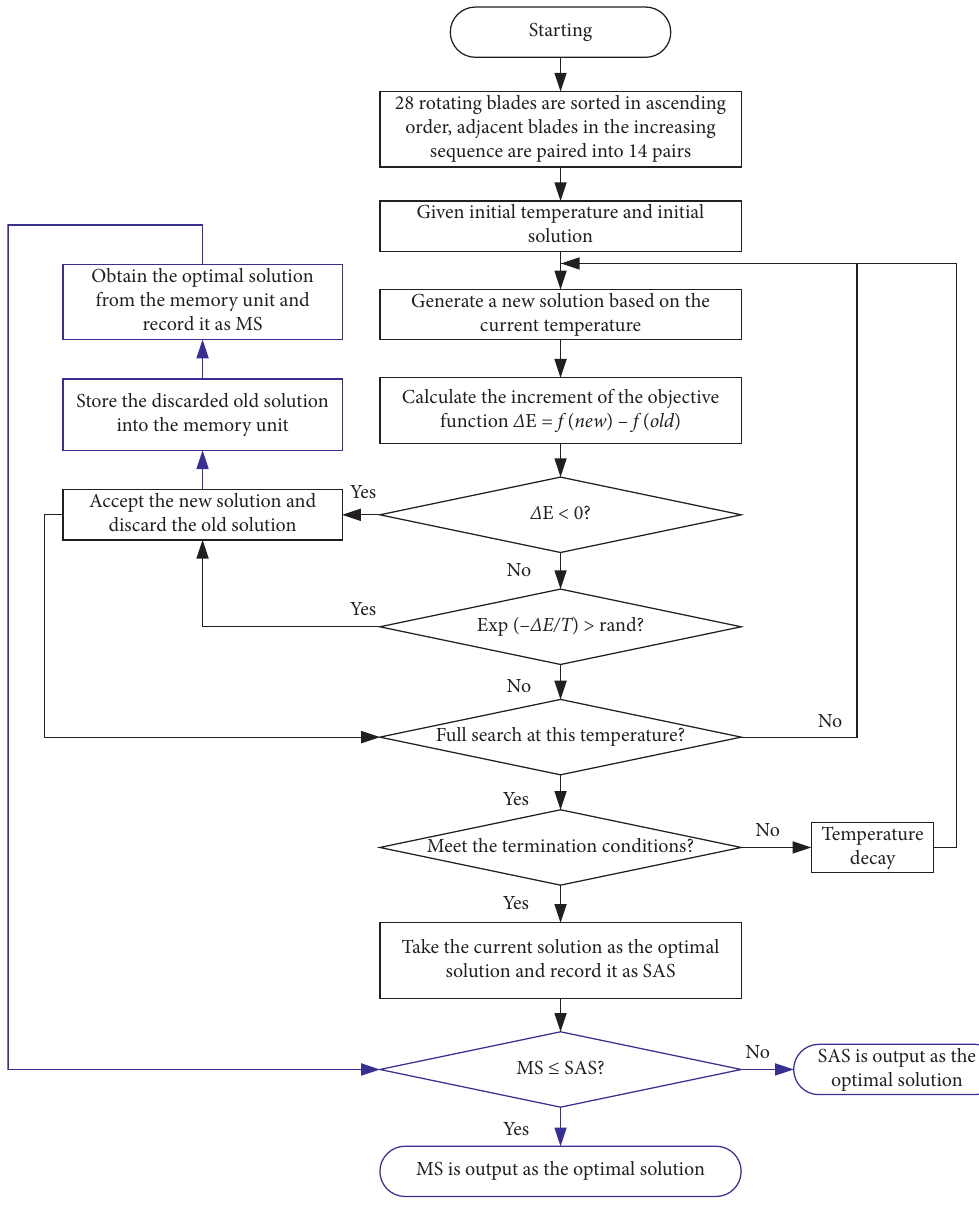
Figure 11: The flowchart of the improved simulated annealing